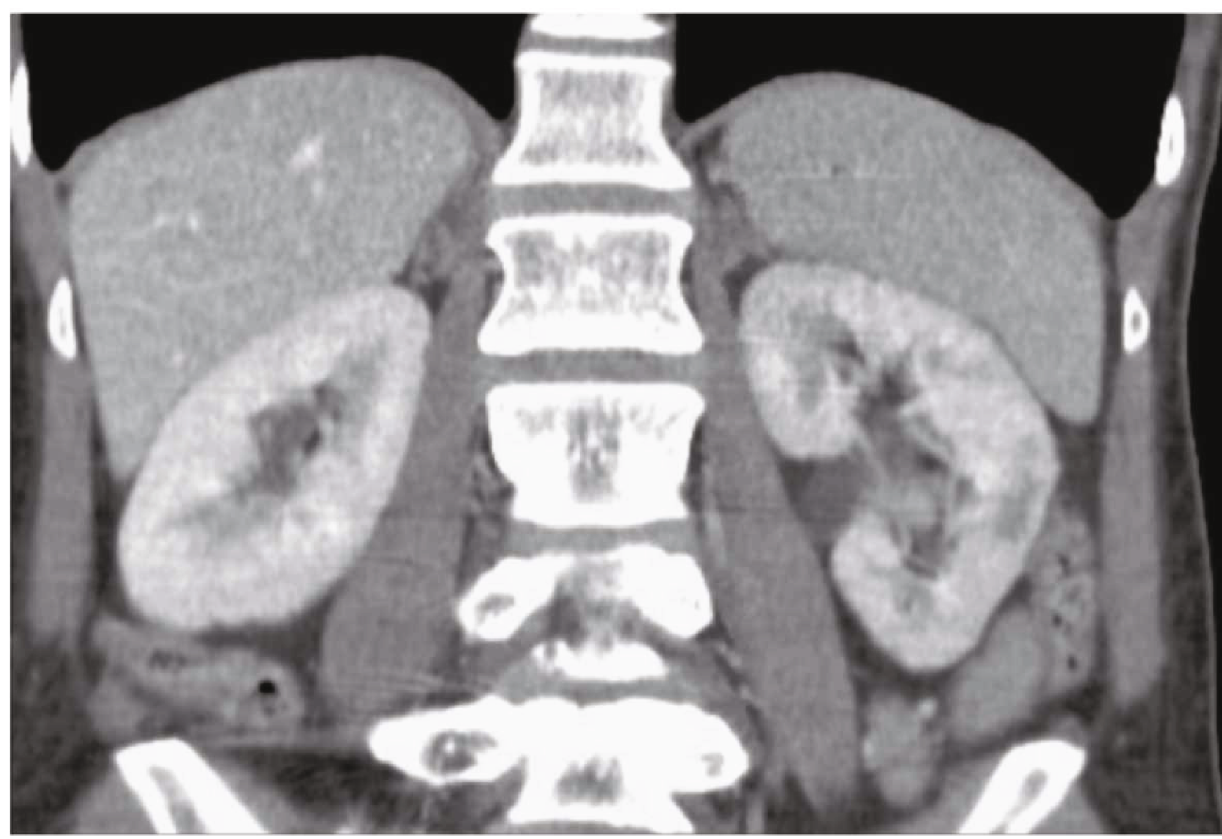
Figure 8: CT angiogram a month later now shows much better renal perfusion with minimal infarcts on the left side, compared to Figure